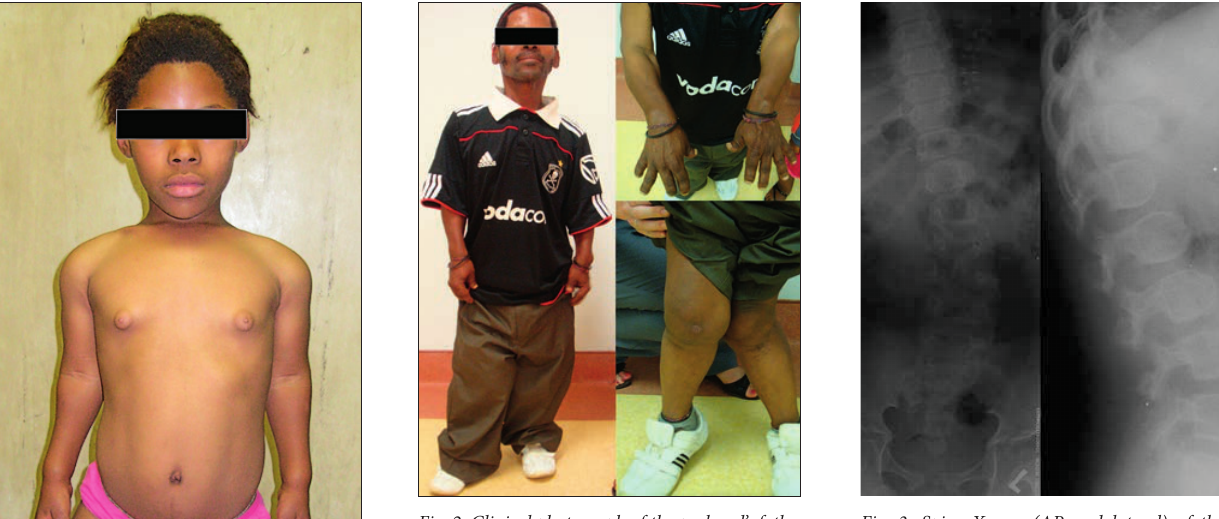
Fig. 3. Spine X-rays (AP and lateral) of the proband show mild scoliosis, anterior beaking and tonguing of vertebral bodies.